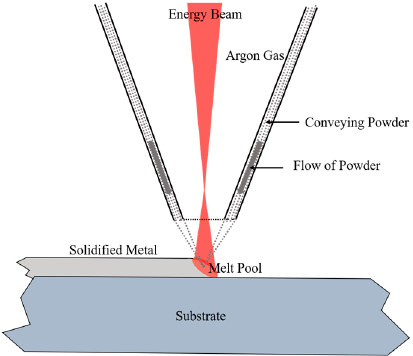
Figure 1. Schematic diagram of laser metal deposition.